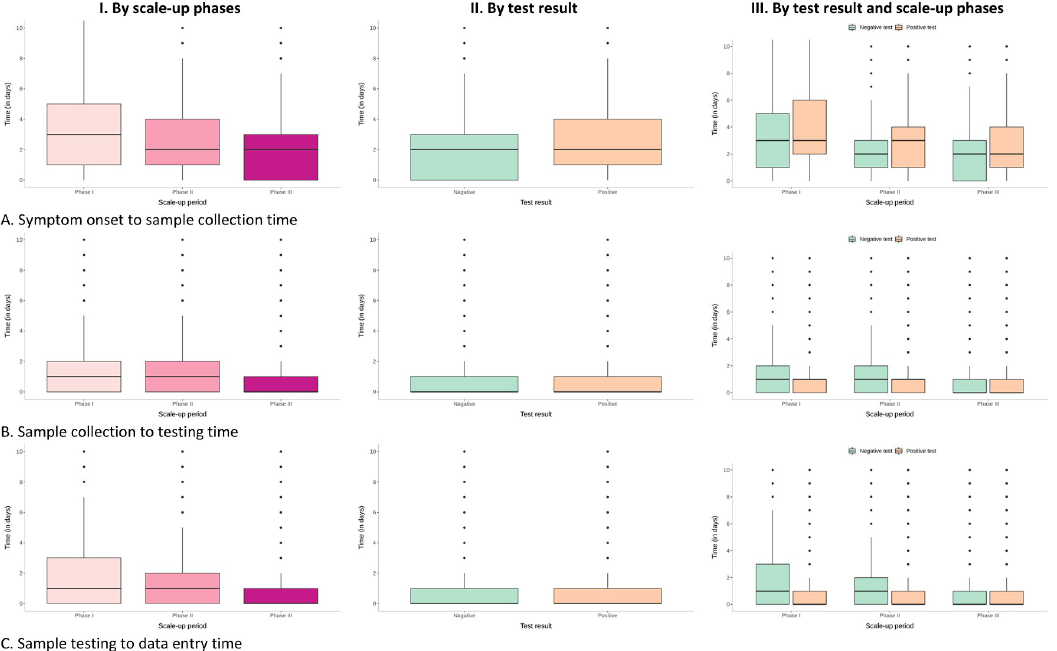
Fig 7. Timeliness of the COVID-19 tests carried out in the laboratory surveillance network by scale-up phases and test results, India (March 2020 to January